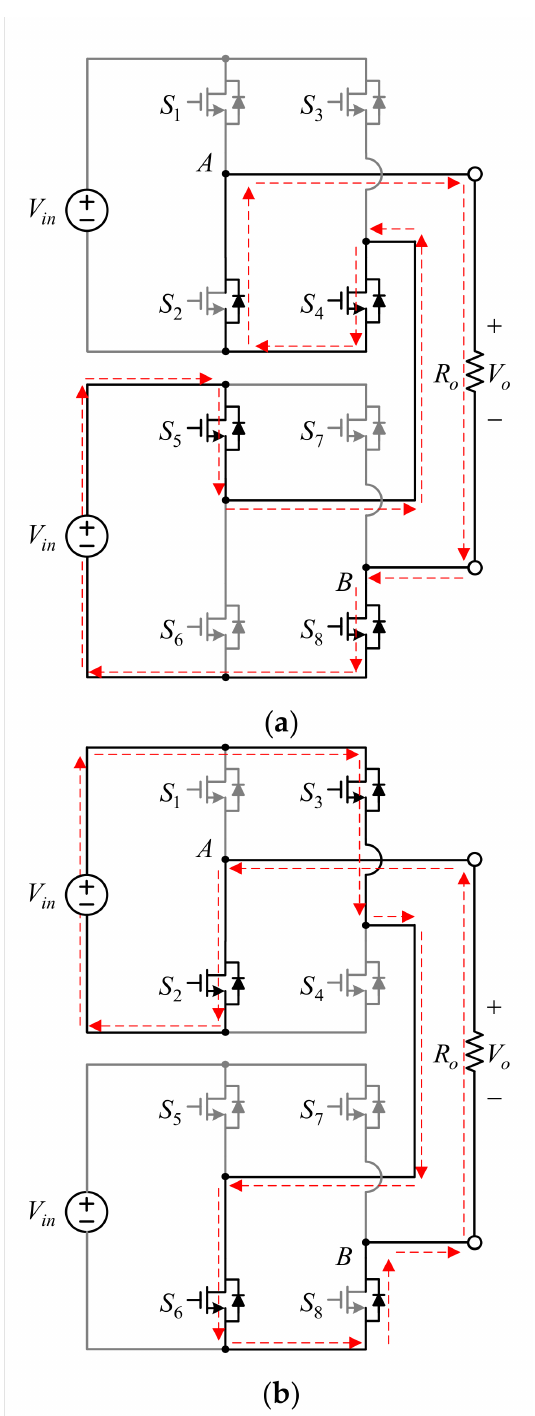
Figure 12. ( a ) Current flow direction of V in voltage output; ( b ) Current flow direction of − V in voltage output. Status III [ V o = 2 V in or − 2 V in ]: When the switches S 1 , S 4 , S 5 , and S 8 are on, and the switches S 2 , S 3 , S 6 , and S 7 are off, the output voltage is 2 V in , and the circuit is displayed in Figure 13a. When the switches S 3 , S 5 , S 7 , and S 8 are on, and the switches S 1 , S 2 , S 4 , and S 6 are off, the output voltage is − 2 V in , and the circuit is displayed in Figure